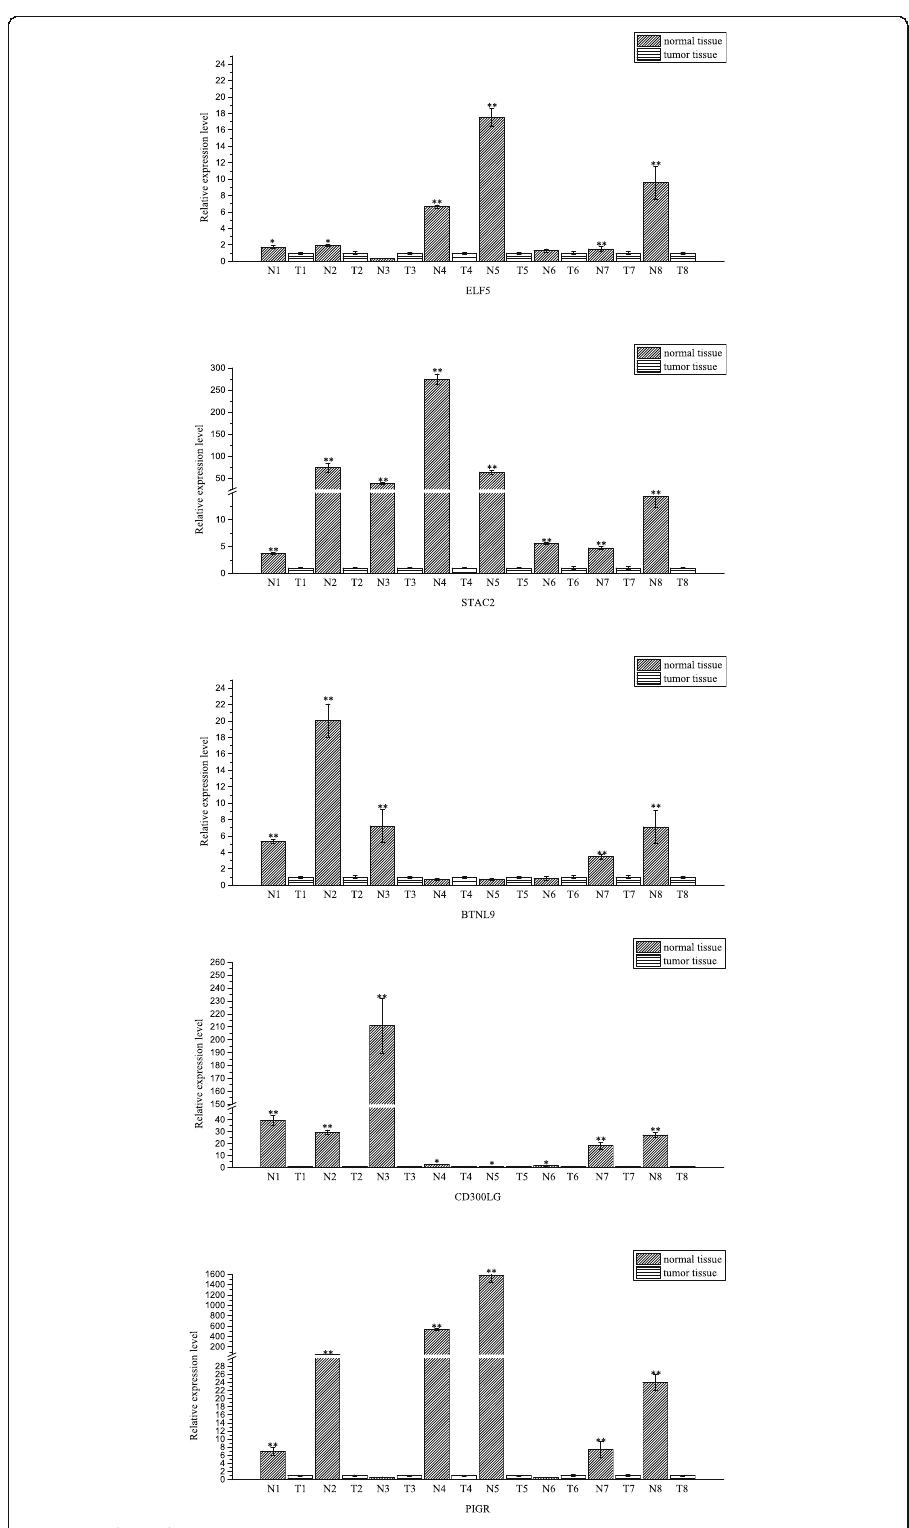
Fig. 7 (See legend on next